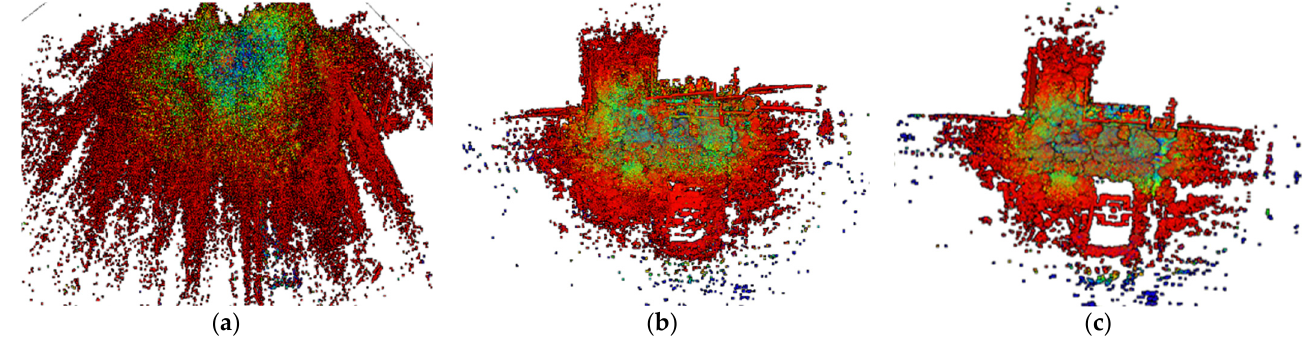
Figure 8. Cloud map of artificial forest points in three paths. (( a ) shows straight-line path; ( b ) shows S-line path; ( c ) shows loop path).